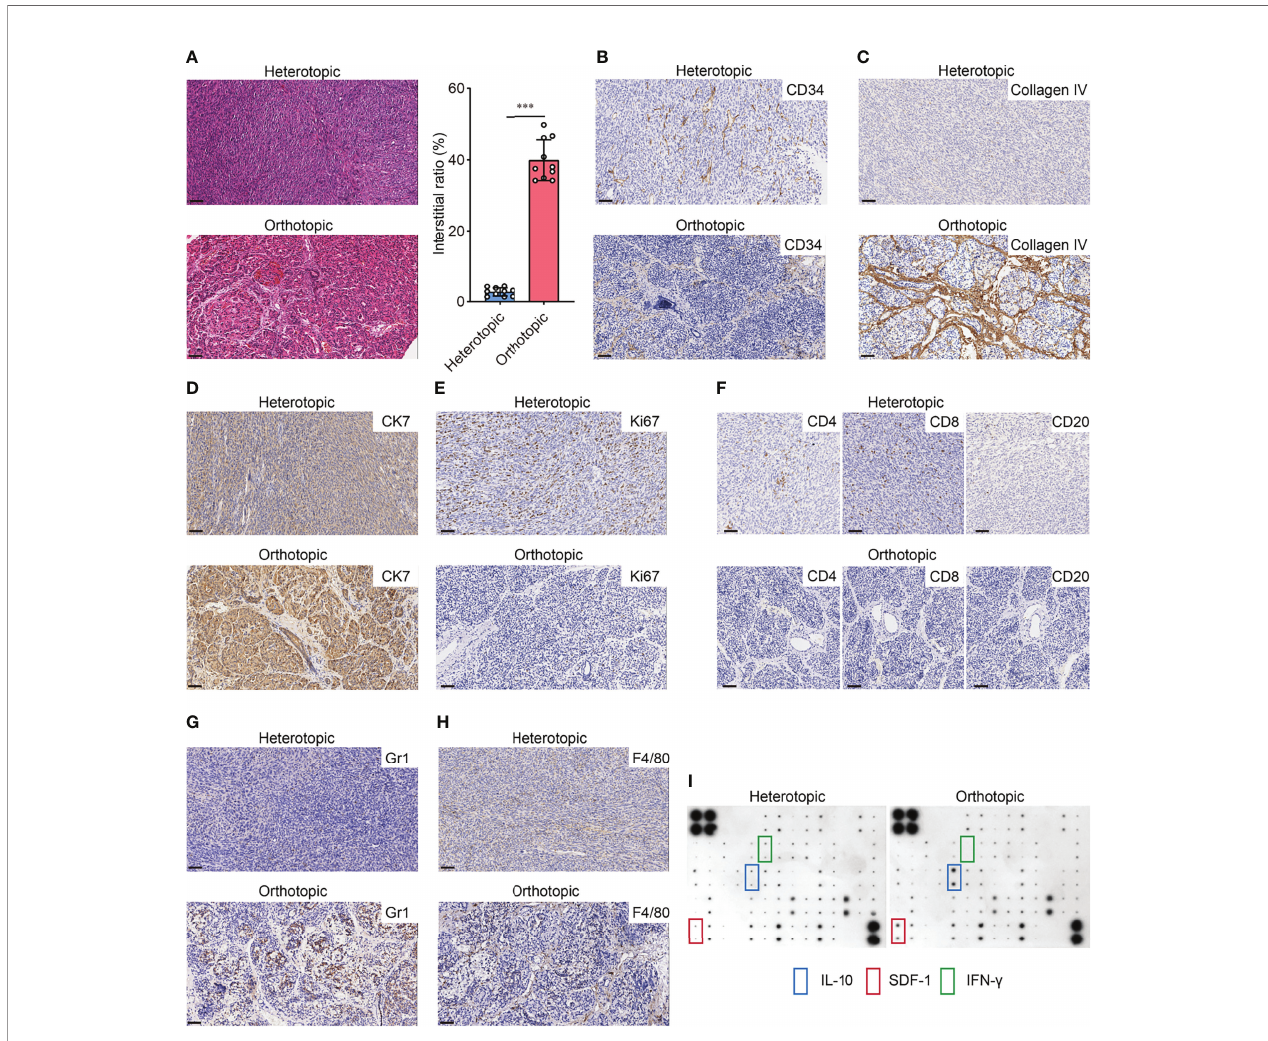
FIGURE 2 | Different immunological microenvironment landscapes of orthotopic and heterotopic graft. (A) H&E-stained pancreatic cancer sections (left) and interstitial ratio (right) calculated by ImageJ of orthotopic and heterotopic grafts (n=10 each, ***p<0.001). Scale bar=50 m m. (B) Representative images of CD34 staining in orthotopic and heterotopic grafts. Scale bar=50 m m. (C) Representative images of Type IV collagen staining in orthotopic and heterotopic grafts. Scale bar=50 m m. (D) Representative images of CK7 staining in orthotopic and heterotopic grafts. Scale bar=50 m m (E) Representative images of Ki67 staining in orthotopic and heterotopic grafts. Scale bar=50 m m. (F) Representative images of CD4, CD8 and CD20 staining in orthotopic and heterotopic grafts. Scale bar=50 m m. (G) Representative images of Gr1 staining in orthotopic and heterotopic grafts. Scale bar=50 m m. (H) Representative images of F4/80 staining in orthotopic and heterotopic grafts. Scale bar=50 m m. (I) Representative cytokine antibody array for orthotopic and heterotopic grafts